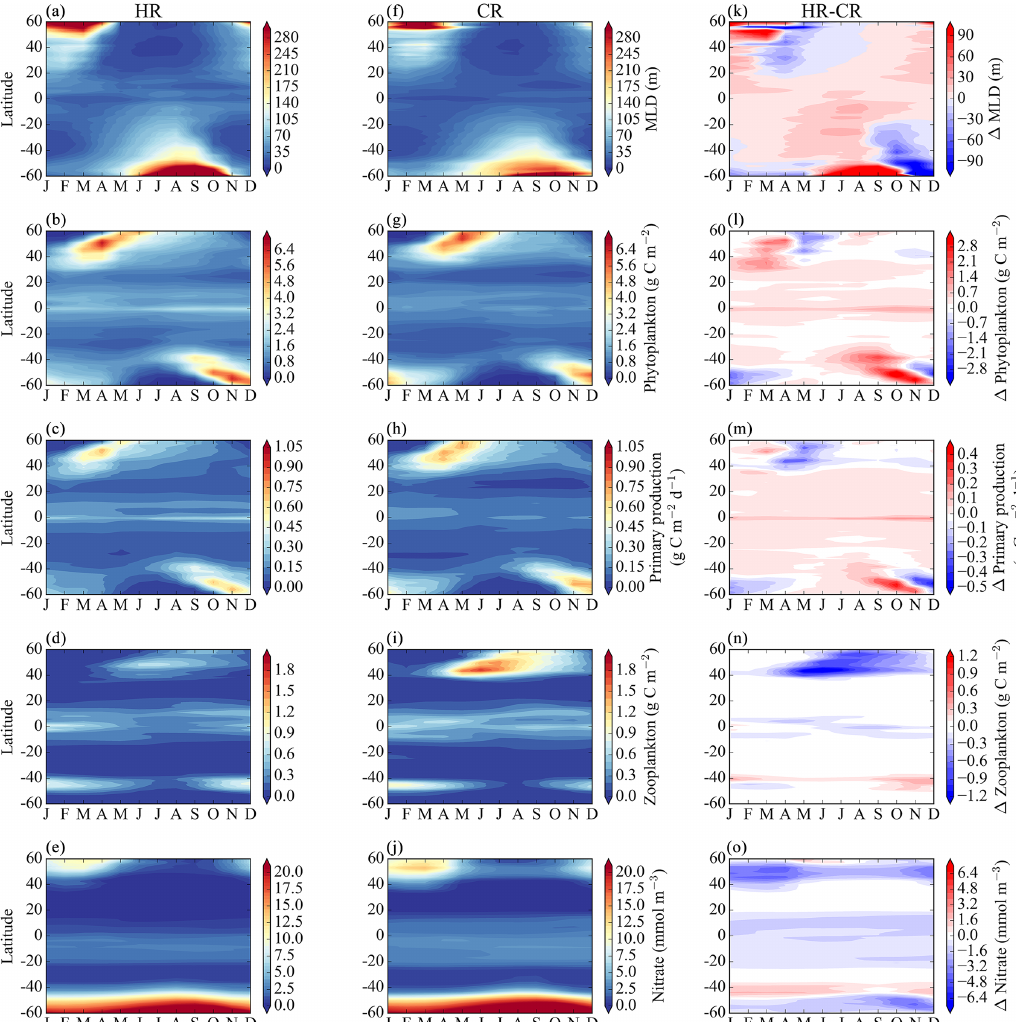
Figure 6. Hovmöller diagram showing the seasonal evolution of zonally averaged model properties for the HR simulation (left column), the CR simulation (middle column) and their difference (right column). First row: mixed layer depth; second row: phytoplankton biomass; third row: primary production; fourth row: zooplankton biomass; fifth row: surface nitrate concentration. The difference is calculated as HR − CR, so positive values indicate larger values in the HR